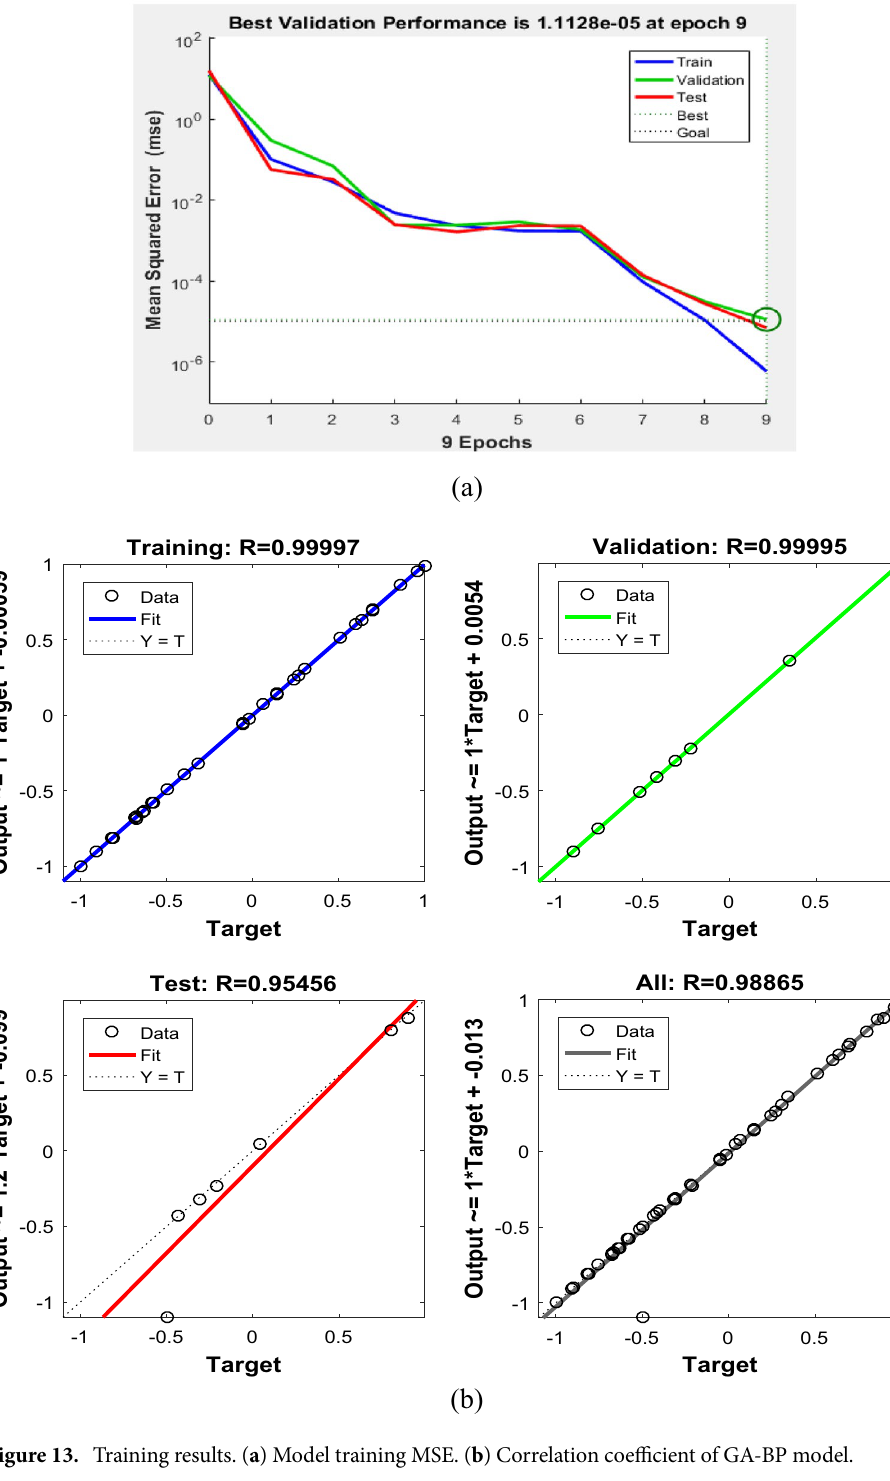
Figure 13b is a matrix data graph with 2 rows and 2 columns. The abscissa is the target value, the ordinate is the output value of the network, and the diagonal line (-Fit) is the best adaptive fitting curve of the target value and the network output value. In order to prevent over-fitting, the method used by MATLAB is to divide the data into three parts. Training is the training data, validation and test are the validation data and test data respectively. The correlation between the trained network output value and the training target value is 0.99997, (b upper left). As the training progresses, the error between the training output data and the training target data becomes smaller and smaller, and the validation and test data are the same. The error is getting smaller and smaller. The